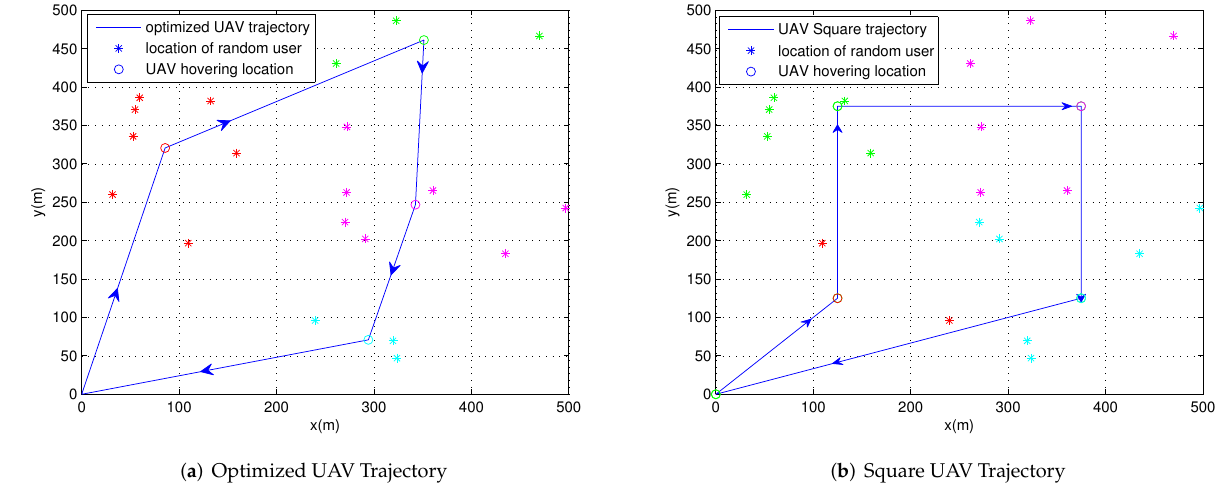
Figure 2. Comparison of the optimized UAV trajectory and the square UAV trajectory, both with the aid of the incremental beam selection and the iterative